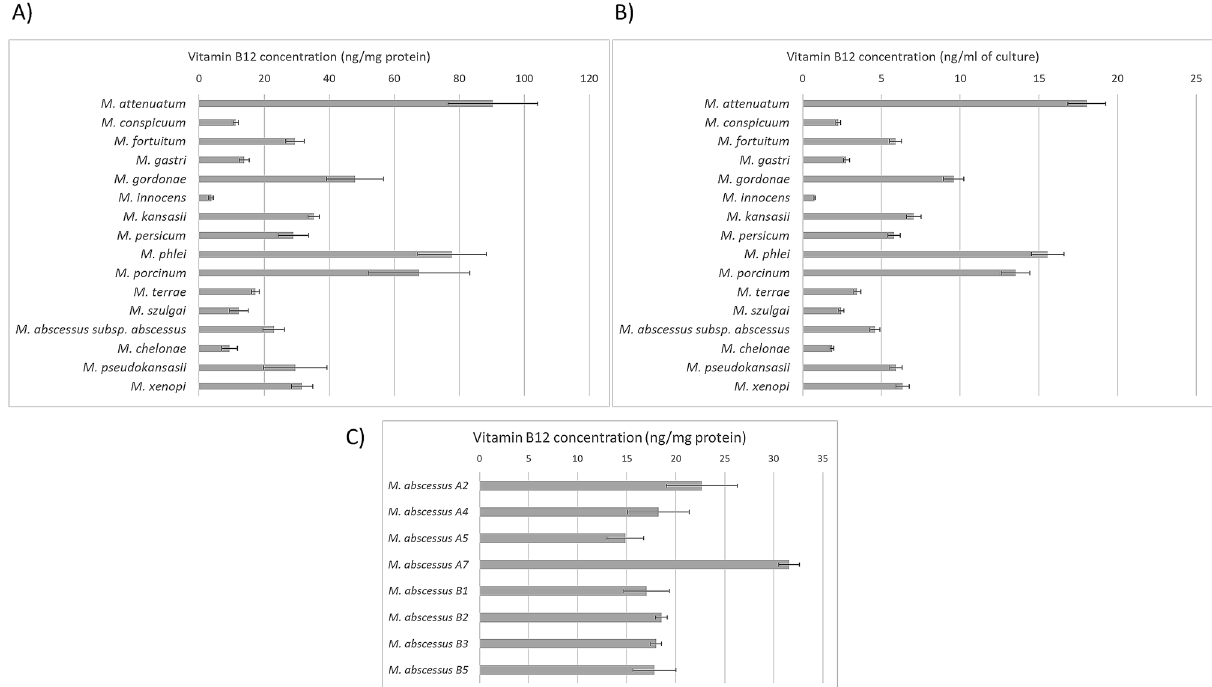
Figure 3. Cobalamin concentration in cell lysates of non-tuberculous mycobacteria. Cobalamin was detected in cell lysates of non-tuberculous mycobacteria by immunoassay. Cells were grown in 7H9 medium supplemented with OADC, Tween 80, and CoCl 2. We cultured cells until the suspension reached OD 600 = 1. Next, cells were harvested and washed with fresh medium without supplements to remove residual medium proteins from the surface. The pellet was re-suspended in Tris buffer and disrupted by beat-beating. The suspension was spinned. We used supernatant to estimate the concentration of vitamin B12 and protein content. Results were obtained from three independent cultures; each lysate was analyzed in two technical replicates. ( A ) cobalamin concentration in cell lysates of non-tuberculous mycobacteria, when normalized in ng per mg of protein, ( B ) cobalamin concentration in non-tuberculous mycobacteria cell lysates, when normalized in ng per ml of culture, ( C ) cobalamin concentration in cell lysates of clinical strains of M. abscessus complex. Whiskers represent